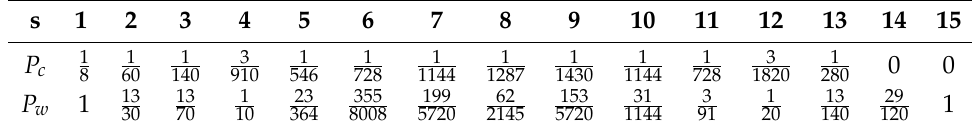
Table 3. Values of P c ( 4,2, s ) and P w ( 4,2, s ) for s ≥